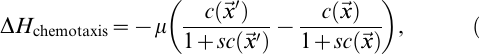
Figure S1 Compactness ( C = A cluster / A hull ) of 128-cell clusters after 5000 MCS ( , 40 h) as a function of the cell length, in the presence (solid curve) or absence (dashed curve) of contact inhibition. Lengths given in terms of the target length L as defined in Merks et al. 2006 [22]. Grey curves show standard deviations over ten